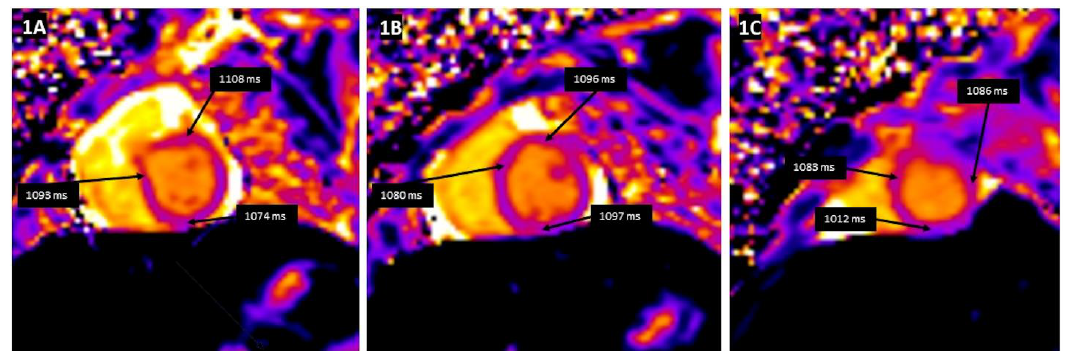
Figure 1. T1 mapping demonstrates a global increase in myocardial T1 relaxation times at the base ( A ), mid-ventricular level ( B ), and the apex ( C ). The average left ventricular myocardial T1 relaxation time is prolonged (1067 msec), and myocardial extracellular volume is elevated (32%).